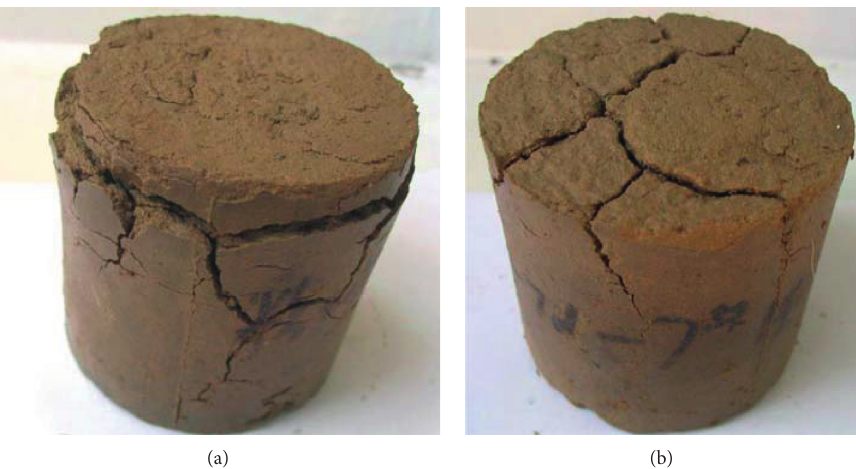
Figure 3: Appearance of representative specimens of group 2 (a) and group 3 (b) after nine cycles in Test